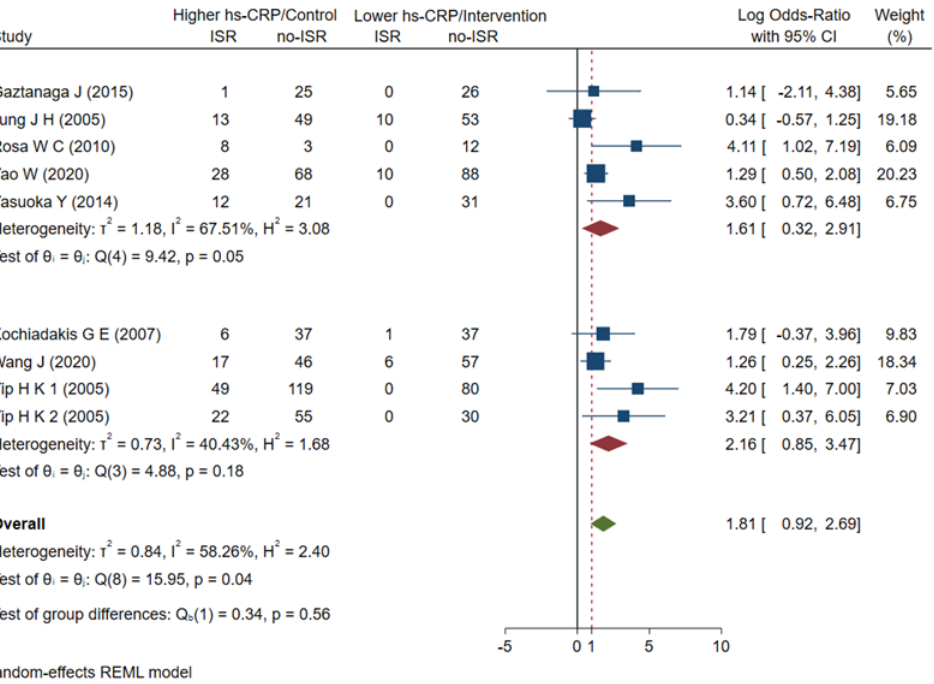
Figure 6. Meta-analysis of ORs in studies evaluating the prognostic value of hs-CRP to restenosis in higher vs lower hs-CRP group as sub-grouped by hs-CRP detecting timepoint. OR: odds ratio, hs-CRP: high-sensitive C-reactive protein, ISR: in-stent restenosis, 0: < 6 (months), 1: ≥ 6 (months) [21–29].